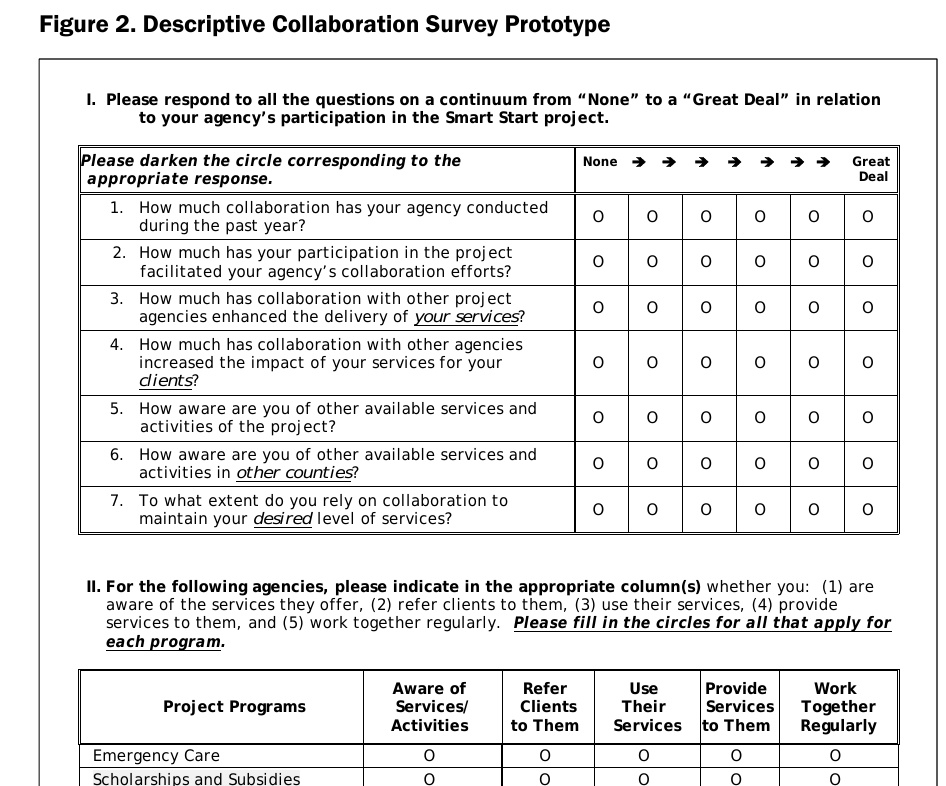
Figure 2. Descriptive Collaboration Survey